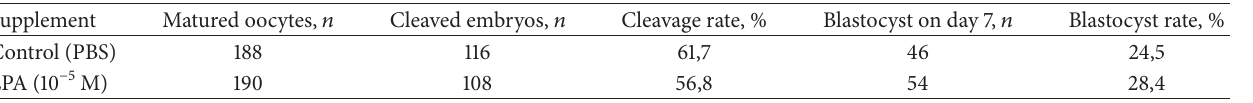
Table 2: The effect of LPA supplementation of in vitro maturation medium on cleavage and blastocyst rates on day 2 and day 7, respectively. Supplement Matured oocytes, 𝑛 Cleaved embryos, 𝑛 Cleavage rate, % Blastocyst on day 7,